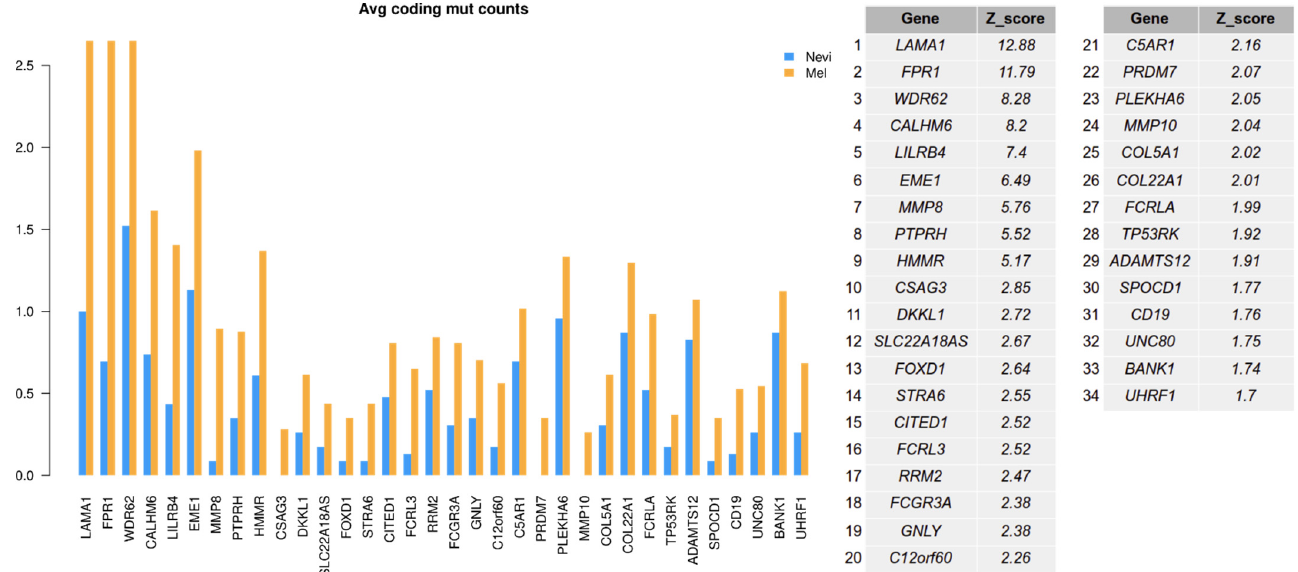
Figure 6. Number of mutations by gene in melanomas compared to benign melanocytic nevi. A mutation analysis was performed from the basic set of samples sequenced by RNA-seq. Only mutated genes of switched isoforms above a sig- nificance score (Z-score) of 1.6 with a 90% confidence interval are shown.